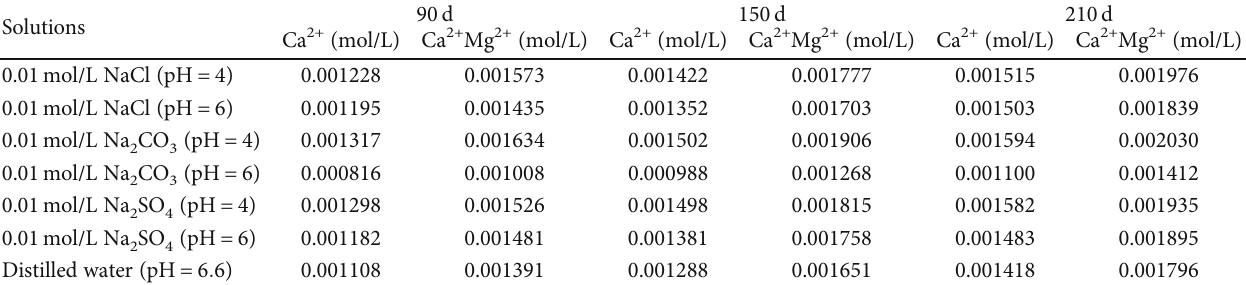
Table 6: Concentrations of Ca 2+ and Mg 2+ in fl owing solutions.